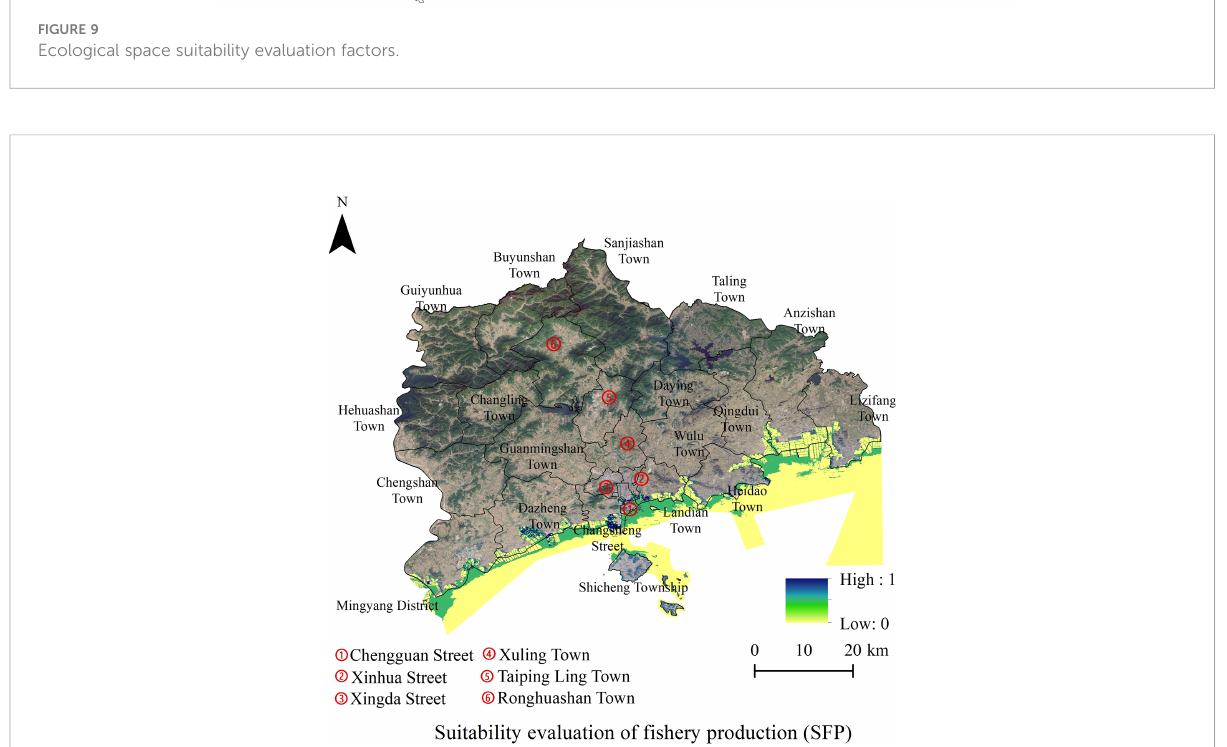
FIGURE 10 Suitability evaluation of fi shery